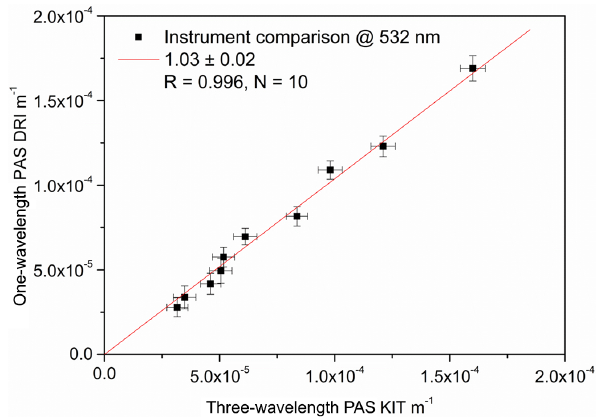
Figure 4. Comparison of two photoacoustic instruments (DRI, PAS KIT) for CAST soot C / O 0.29 at